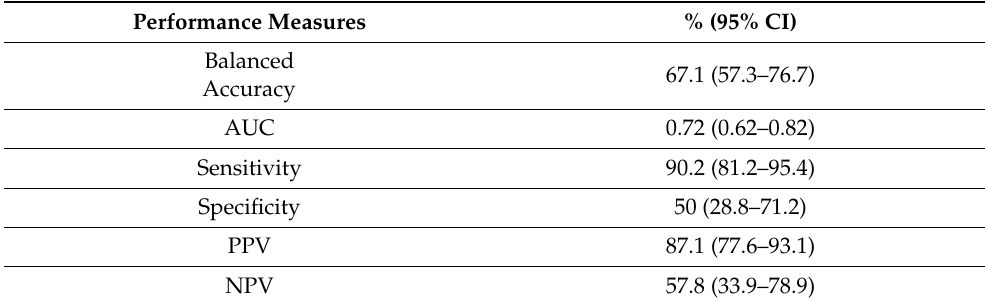
Table 4. Final gradient boosting model performance measures.